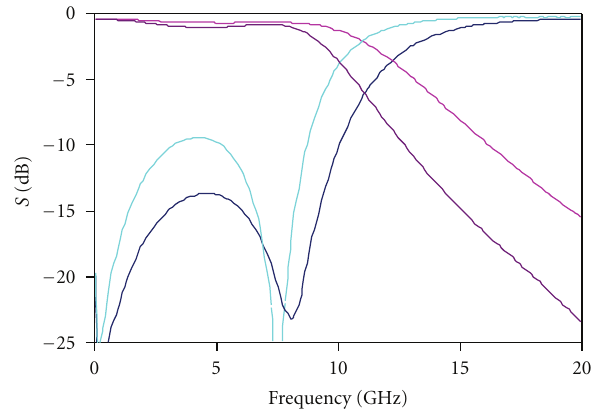
Figure 6: The measured filter performances at higher resolution in